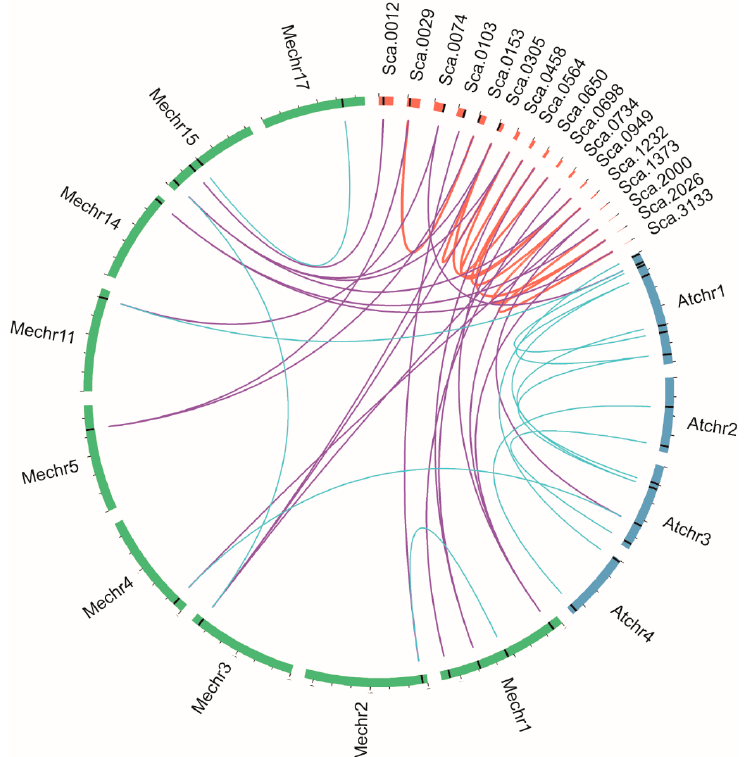
Figure 7. Segmental duplication of HbMPK genes and syntenic analysis of Hevea , M. esculenta , and A. thaliana MPKs. Chromosomes and scaffolds are shown in different colour in circular form. The positions of the MPK genes are marked by black lines on the circle. Duplicated MPK pairs in Hevea are connected by red lines. Syntenic relationships between Hevea and the other two species are connected by purple lines. Blue lines indicate MPK pairs between or inside M. esculenta and A. thaliana . Table 3. The Ka / Ks ratios of duplicated MPK genes in Hevea .